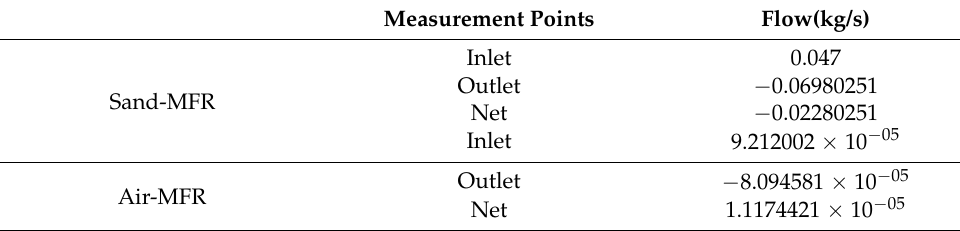
Table 2. Mass flow rate for sand and